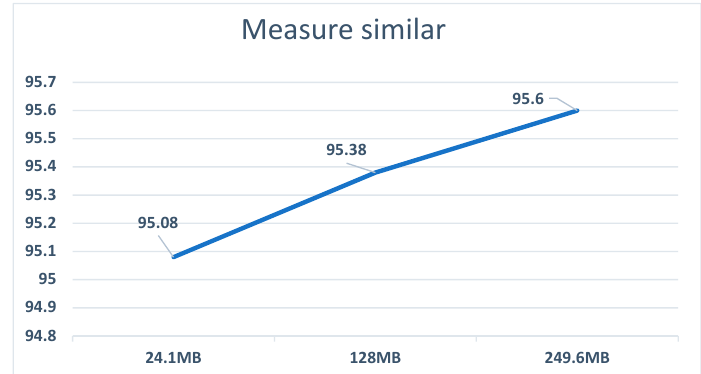
Figure 2. Comparison of similarity among different training datasets.